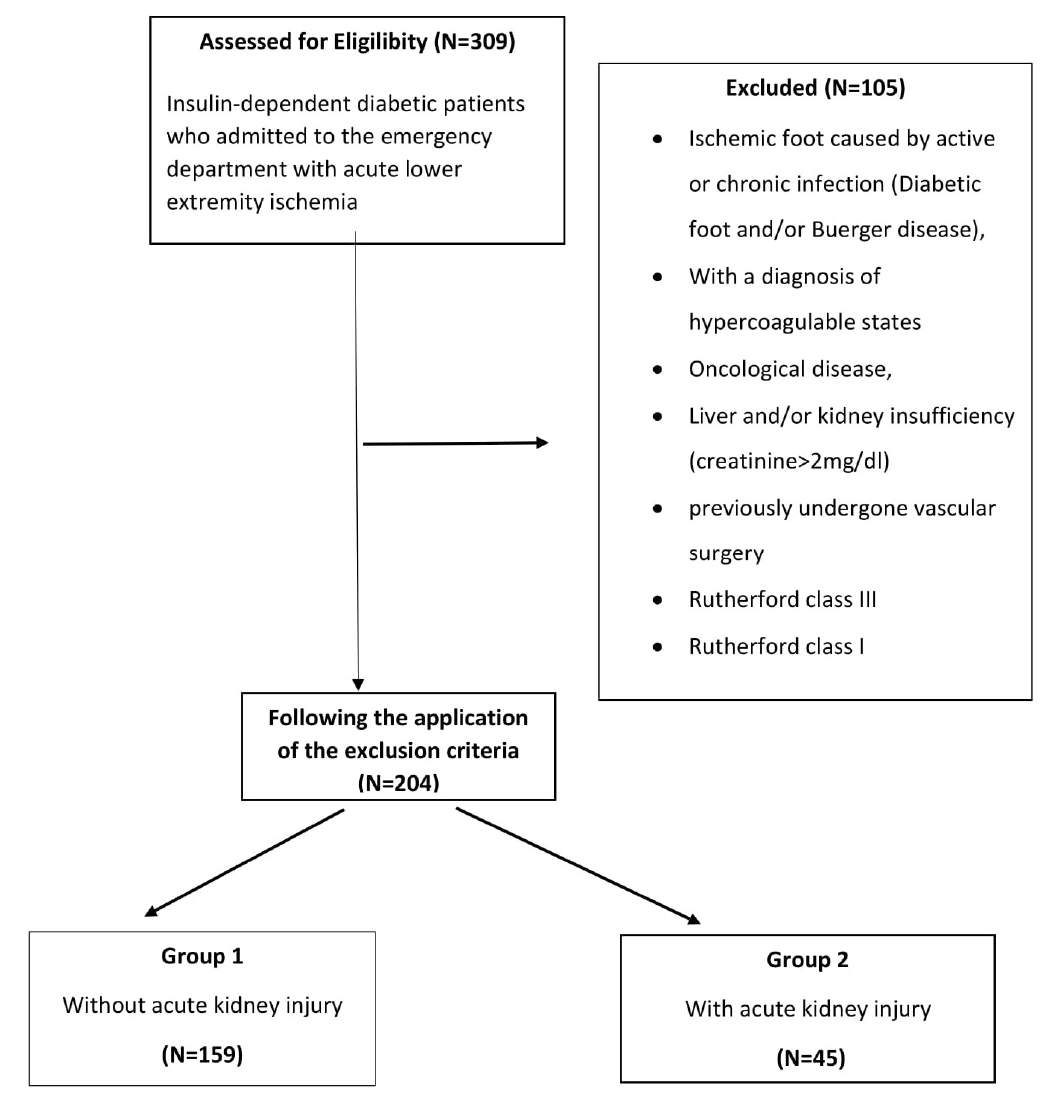
Figure 1. Flowchart of patient enrollment.